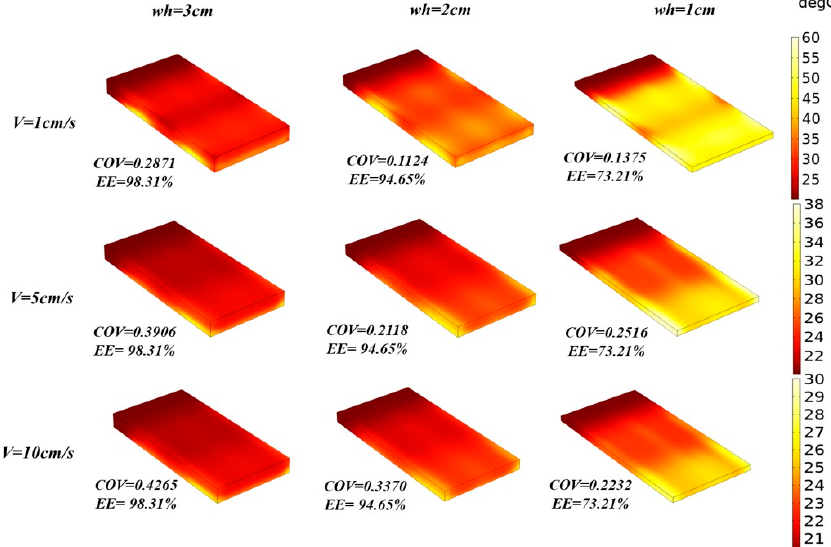
Figure 7. Effect of water flow and water velocity on heating uniformity (wh indicates the liquid thickness, and v represents the velocity).